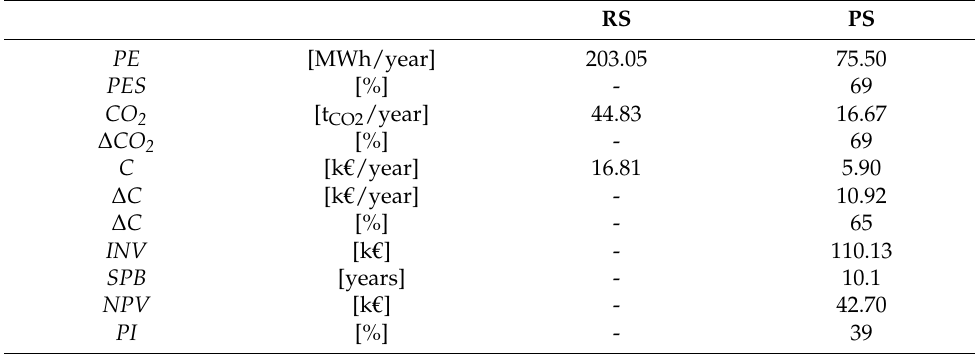
Table 5. Results from the thermoeconomic analysis.